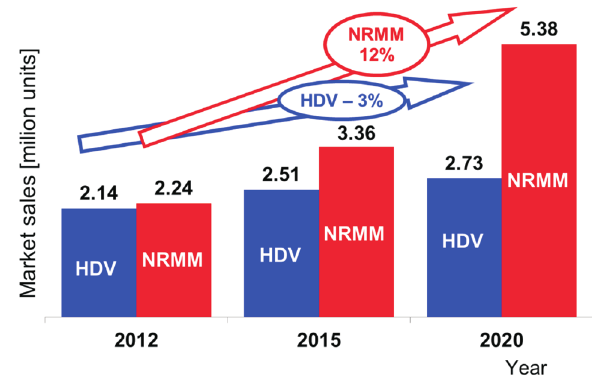
Fig. 2. Sales of HDV and NRMM vehicles (2020 – forecasted) [2] The main problem in relation to the NRMM vehicles